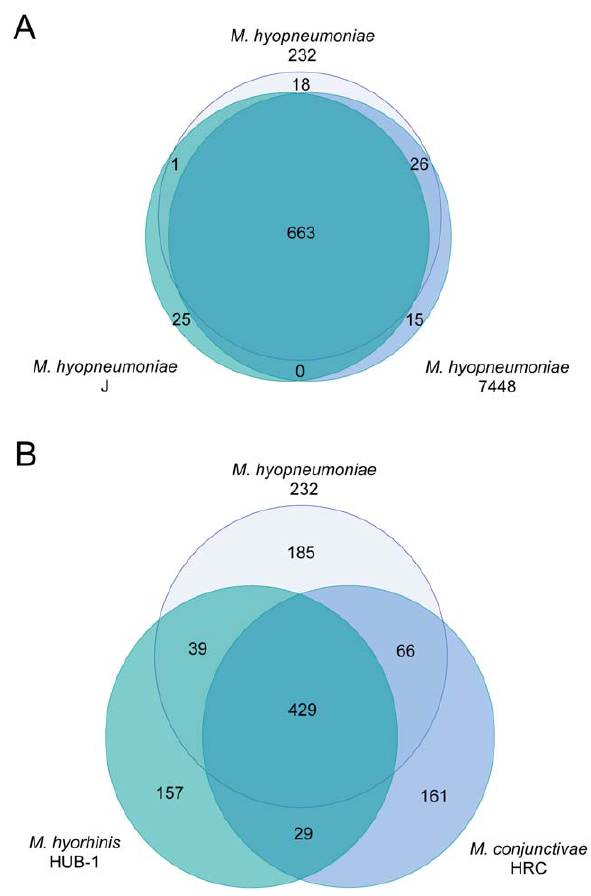
Figure 1. Venn diagram for two sets of three taxa. Above are taxa of the same species and below are taxa of different species. The surfaces are approximately proportional to the number of genes. doi:10.1371/journal.pone.0035698.g001 according to COGs classification (Table S2), which highlights the need for better functional characterization of these genes.